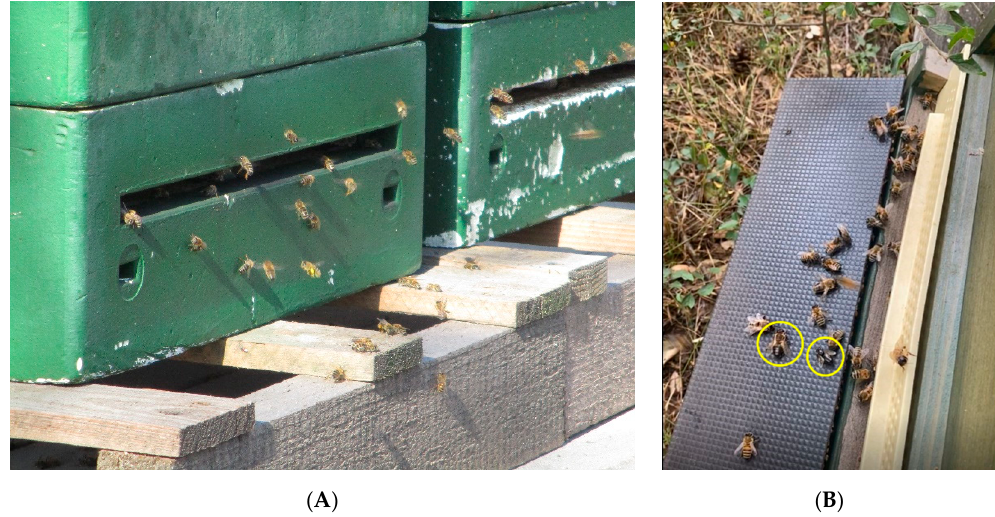
Figure 3. ( A ) Observation of the entrance hole enables a first evaluation of colony strength and activity according to season, weather and environment. © Julia Dittes. ( B ) Alighting board of a Chronic Bee Paralysis Virus-infected honeybee colony with some black hairless individuals (yellow circles). © Silvia Heisch.